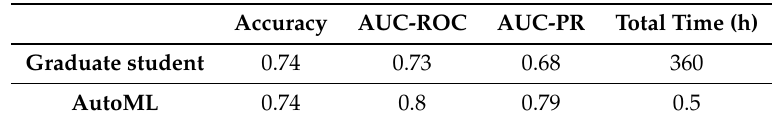
Table 4. Comparison of AutoML and graduate student’s classification performances and total time on the Cardiovascular test set.